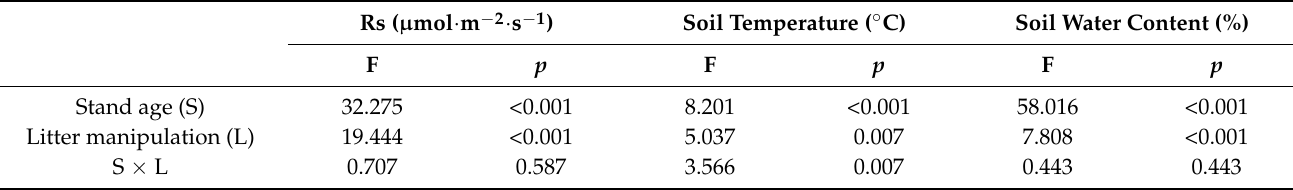
Figure 1. The monthly pattern of soil respiration rate under litter manipulation during the study period (May to October in 2018) in different-aged Betula platyphylla forests of permafrost region, Northeast China. Stand ages included 25 ( a ), 40 ( b ) and 61 ( c ). Litter manipulation included NL (no-litter), DL (double litter) and CK (control litter) in each stand. Error bars indicate the standard deviation ( n = 9). Lowercase letters represent significant differences under the same month and varied litter manipulation ( p < 0.05). Table 2. Effects of stand age and litter manipulation on soil respiration rate (Rs), soil temperature and soil water content in different-aged Betula platyphylla forests of permafrost region, Northeast China.